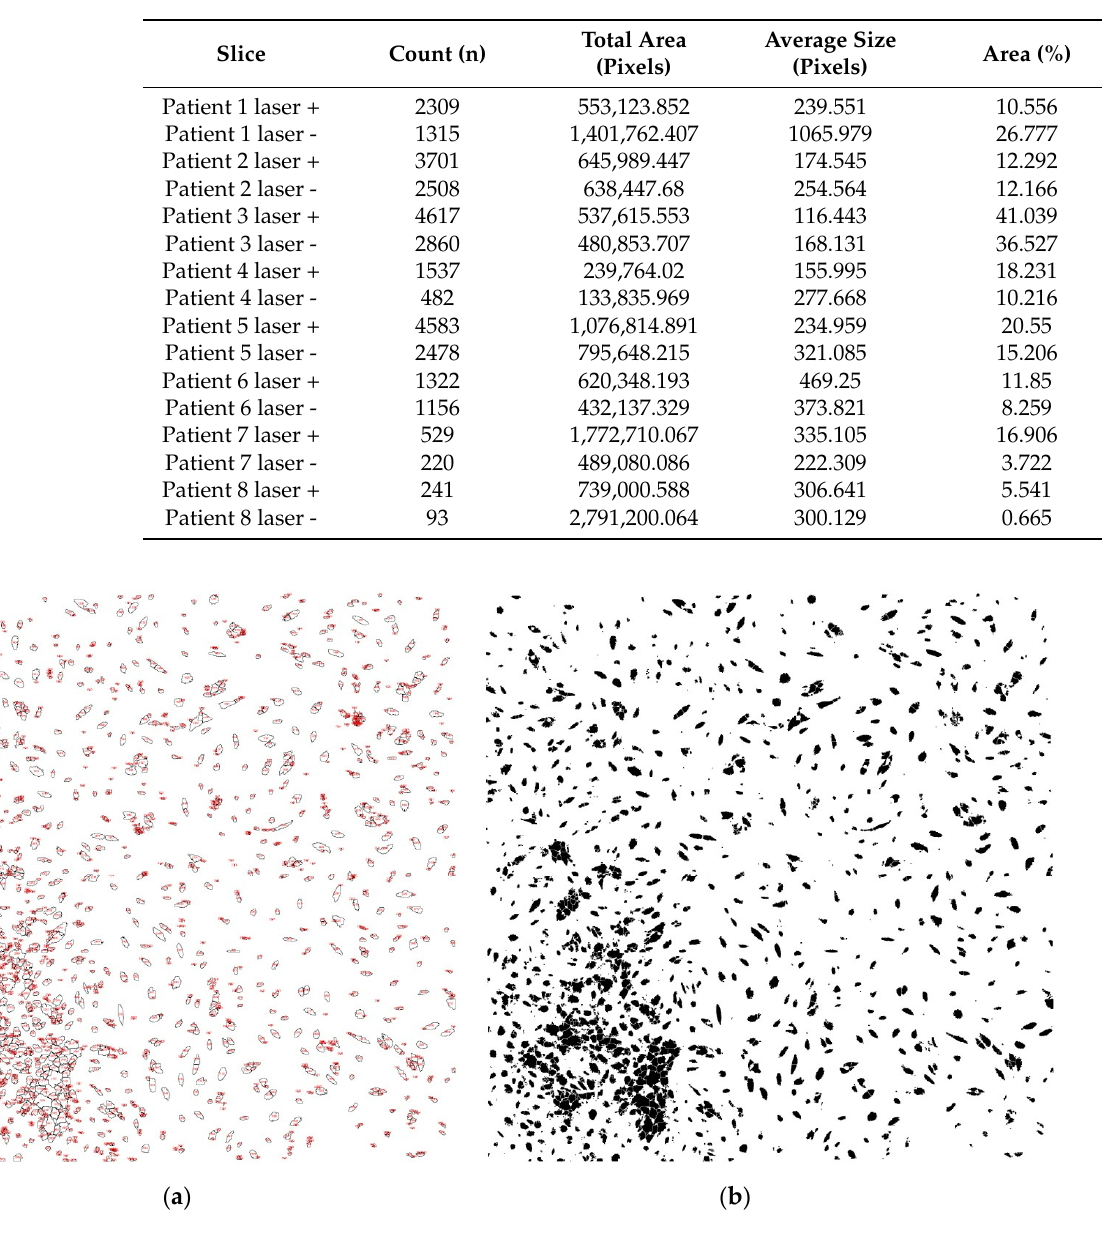
Table 4. Characteristics of the osteoblast cultures.